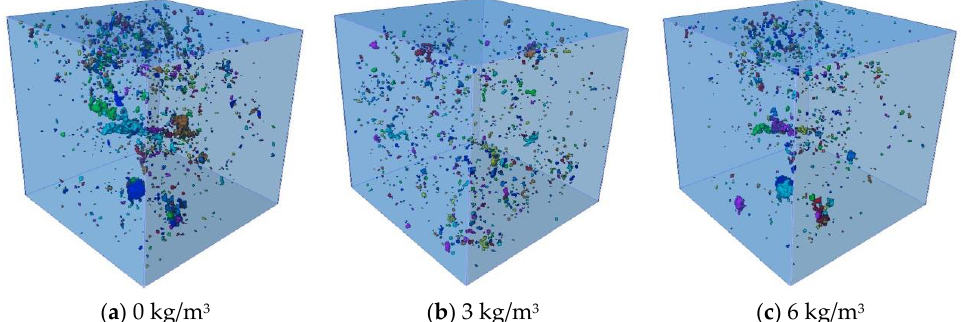
Figure 6. The distribution of pore and crack of specimens.